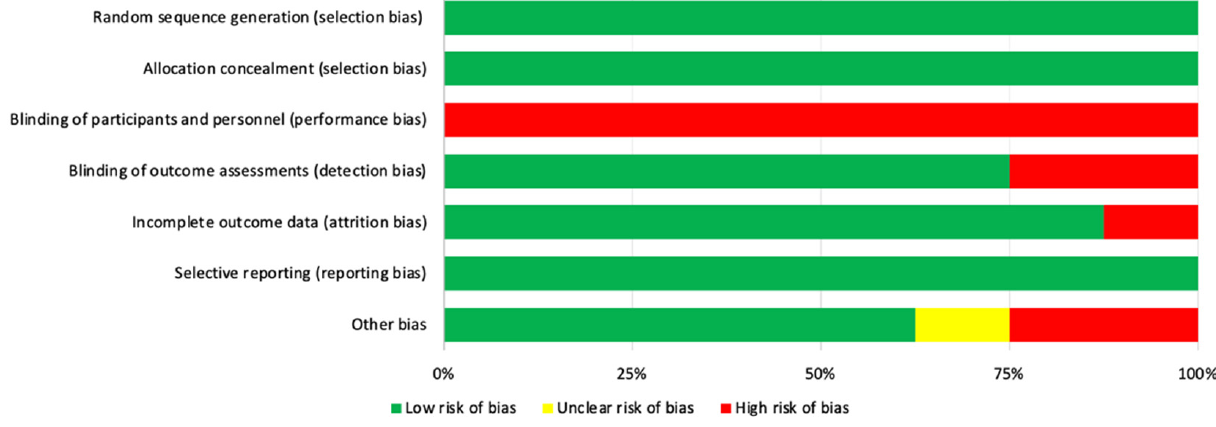
Figure 3. Overall risk of bias. The results are presented by percentages.